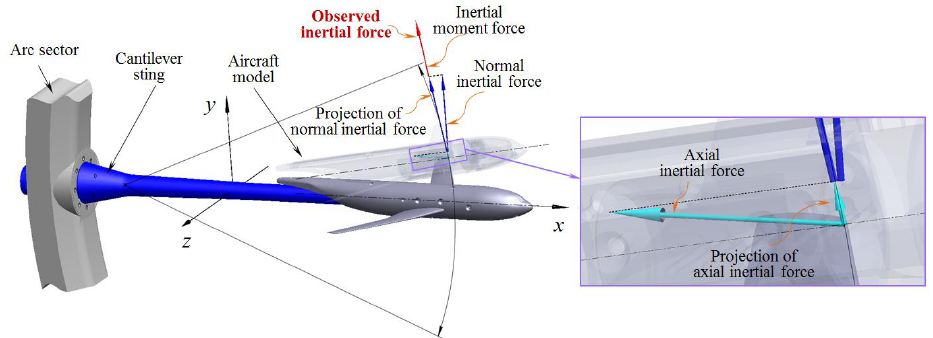
Figure 4. Unified observation of vibration in the pitch plane. At time t , the inertial forces are respectively generated in the x -axis direction, the y -axis direction, and the tangential direction of the pitch moment Mz . The normal inertial force can be